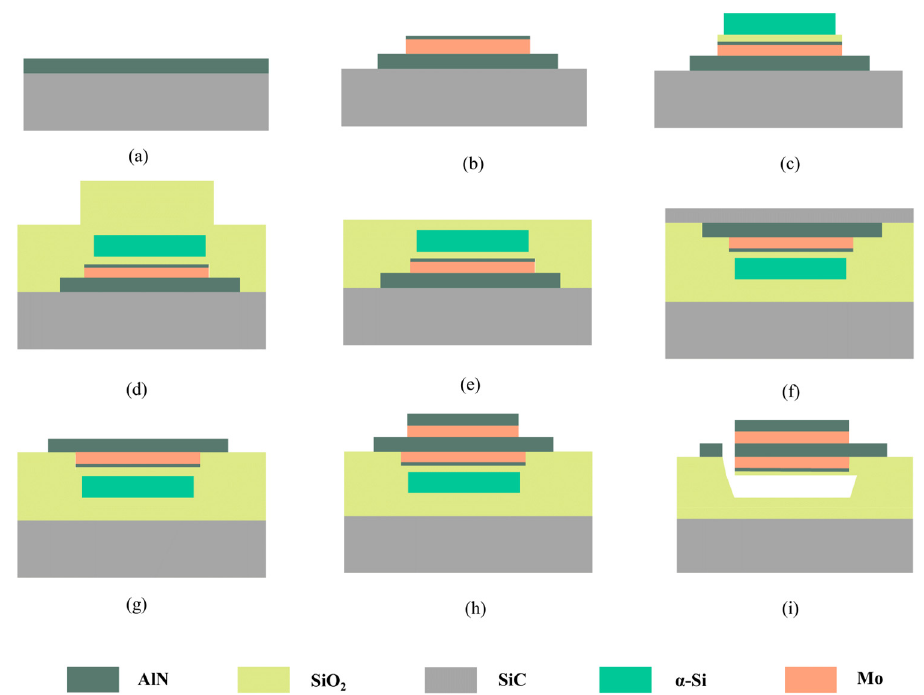
Figure 1. The fabrication process of the single crystal AlN-based BAW filter. ( a ) Deposit single crystal AlN piezoelectric film, ( b ) form the bottom Mo electrode and AlN passive layer by photolithography and etching, ( c ) deposit SiO 2 and sacrificial α -Si layers in sequence, ( d ) deposit 5- µ m SiO 2 to form the bonding layer, ( e ) remove the surface steps by CMP, ( f ) bond SiO 2 surface of the wafer to another SiC wafer, ( g ) thin SiC by CMP and etch it with SF6, ( h ) form the top electrode and AlN passive layer by photolithography and etching, ( i ) etch vias to α -Si and release the BAW by removing the sacrificial layer underneath. Note that the dimensions in the drawings are scaled for sim- plicity.